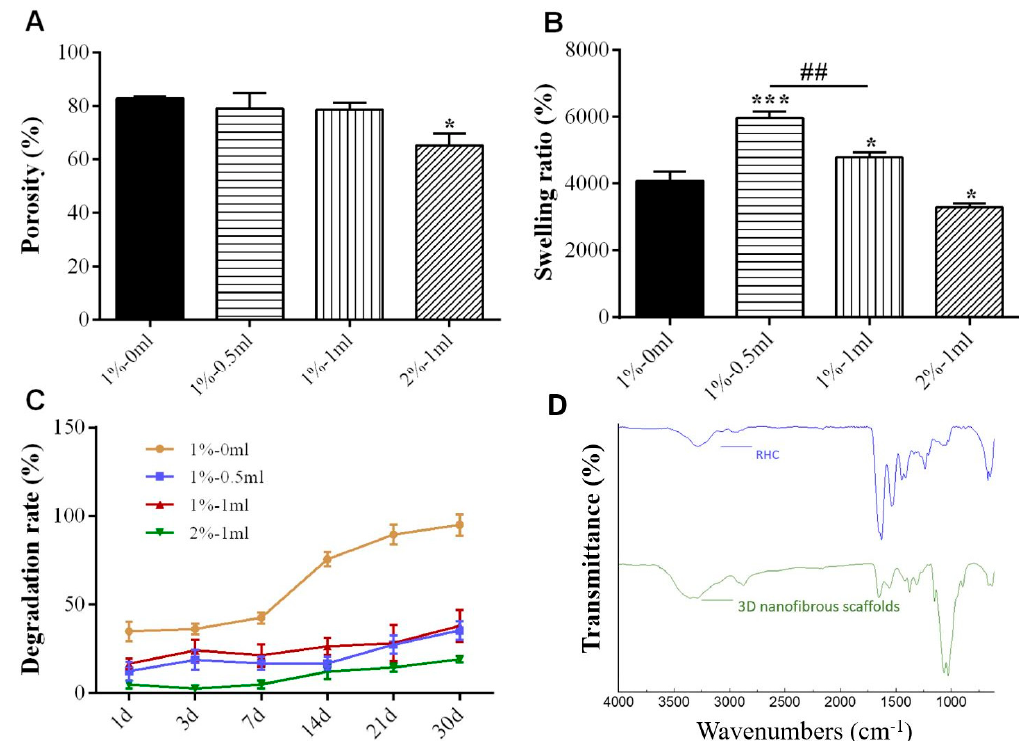
Figure 3. Characterization of the different scaffolds. ( A ) Porosity. ( B ) Swelling ability. ( C ) Degradation rate in a lysozyme solution. ( D ) Spectra obtained from RHC and 3D nanofibrous scaffold in FT-IR tests. * p < 0.05, *** p < 0.001, compared with pure chitosan/RHC scaffold, ## p < 0.01. Bars represent mean ±SD, number of repeats n = 3.